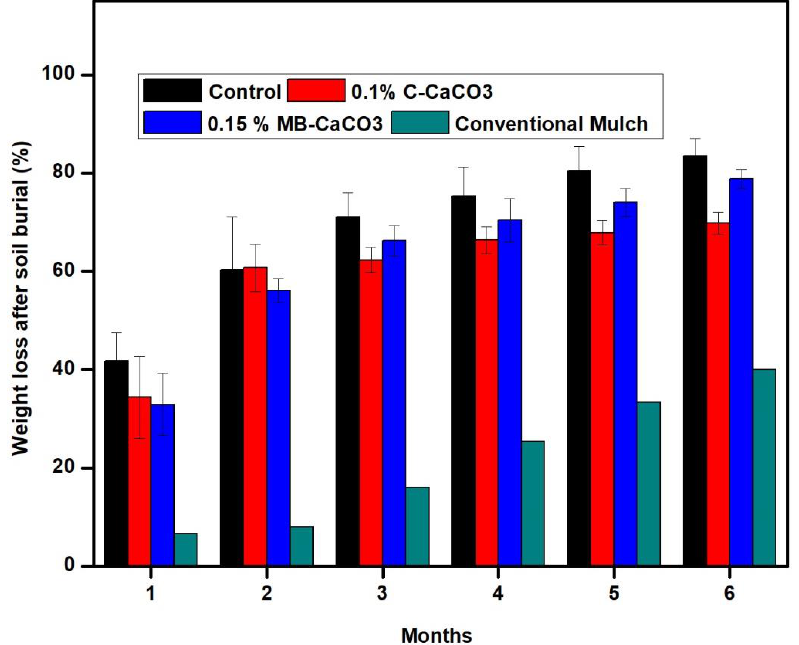
Figure 5. Weight loss changes (%) for 6-month soil burial test.